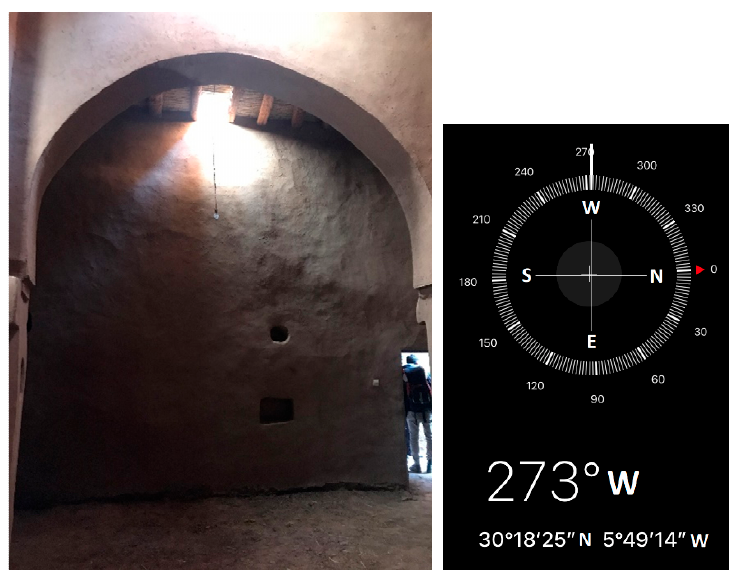
Figure 16. Orientation of the synagogue (the compass from the iPhone).